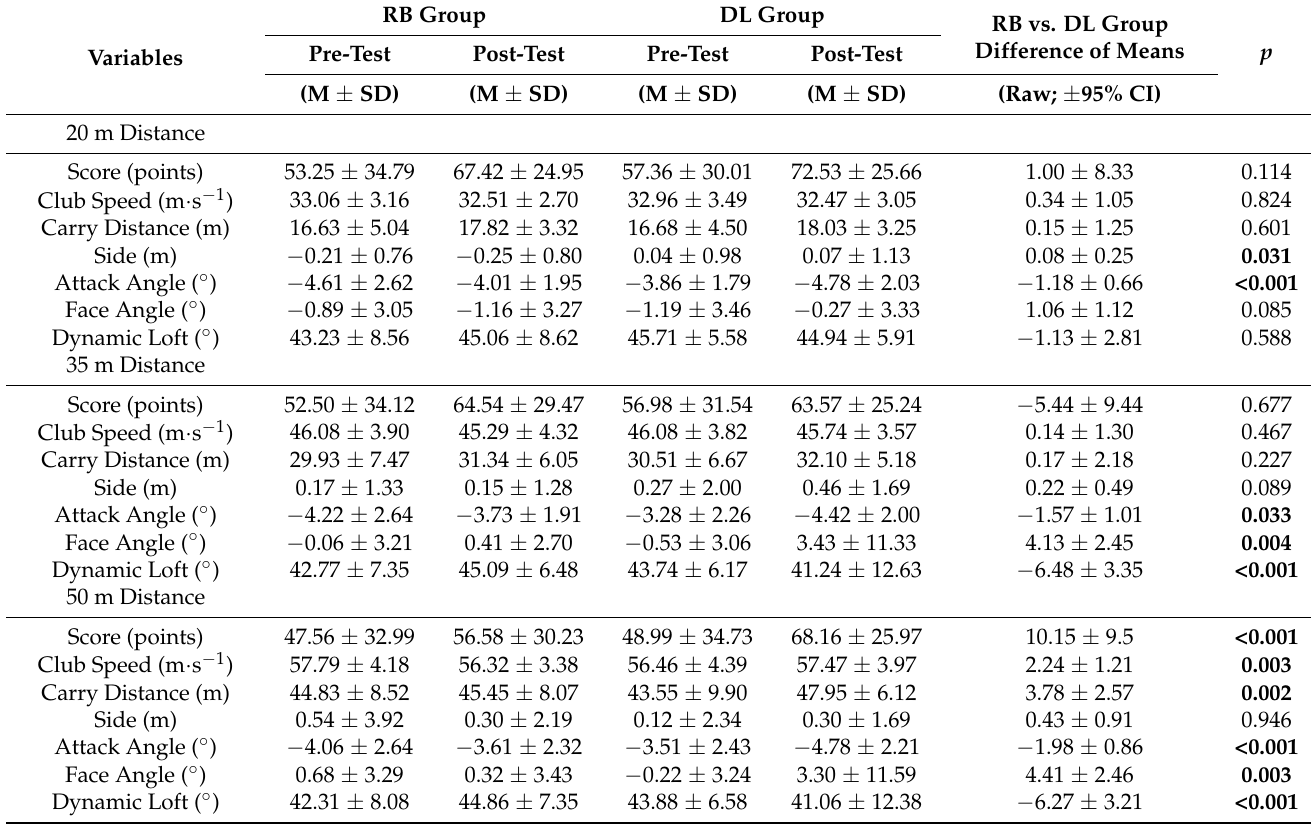
Table 3. Descriptive (M ± SD; Raw; ± 95% CI) and inferential results for the golf shot performance according to the DL and RB